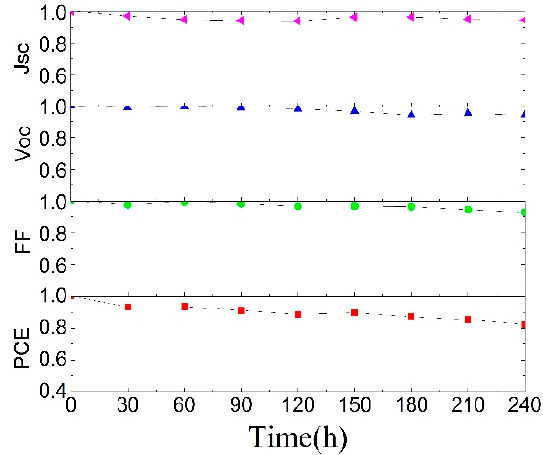
Figure 3. Parameter variations of the inverted devices at different storage times in air. The tests were conducted under ambient air conditions and a humidity of around 40% without any encapsulation.